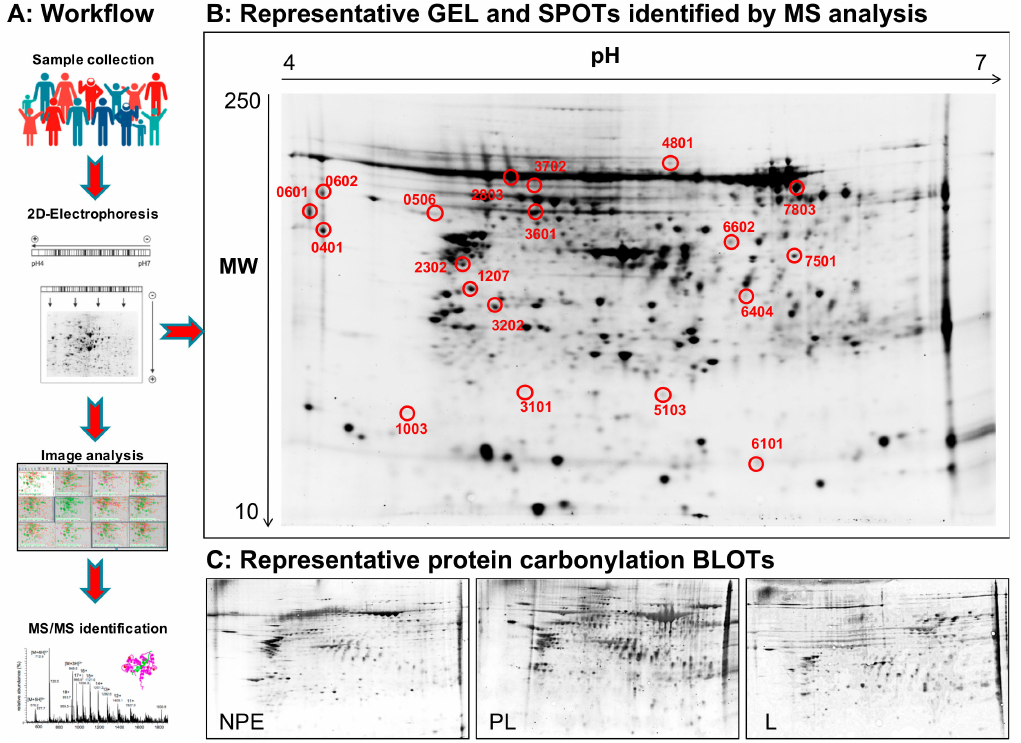
Figure 4. Two-dimensional (2D) electrophoresis images. Panel A : Workflow of redox proteomics approach employed in the study. Panel B : Representative 2D gel from NPE samples showing position and ID number of the spots identified to be di ff erentially carbonylated in both PL vs. NPE and PL vs. L comparisongroups. ProteinsmatchingIDspotsnumbersarereportedinTable2. Panel C :Representative 2D blots from NPE, PL and L samples showing the di ff erent amount of total protein